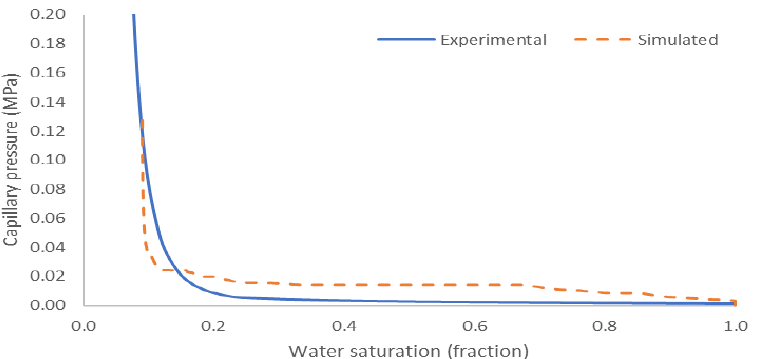
Figure 7. Experimental and numerical simulated primary drainage capillary pressure curves for the coquina sample considered in this work.